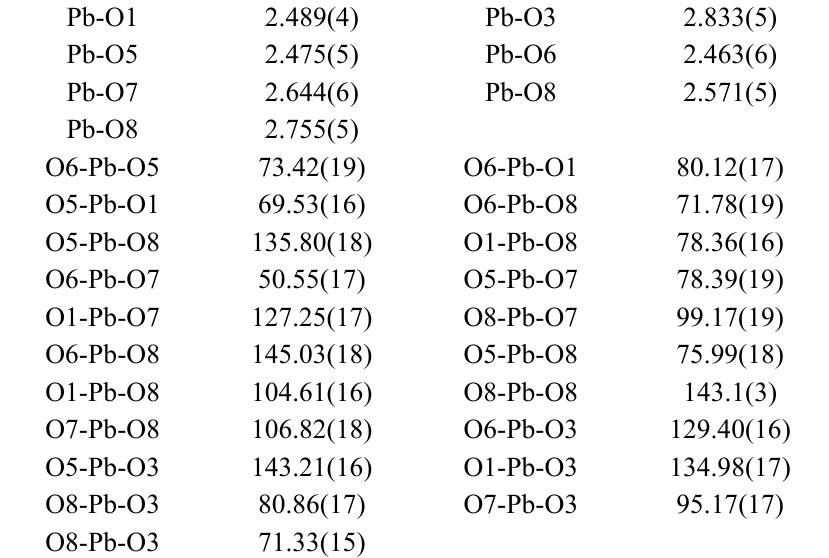
Table 3. Selected bond lengths (Å) and angles (°) of 2